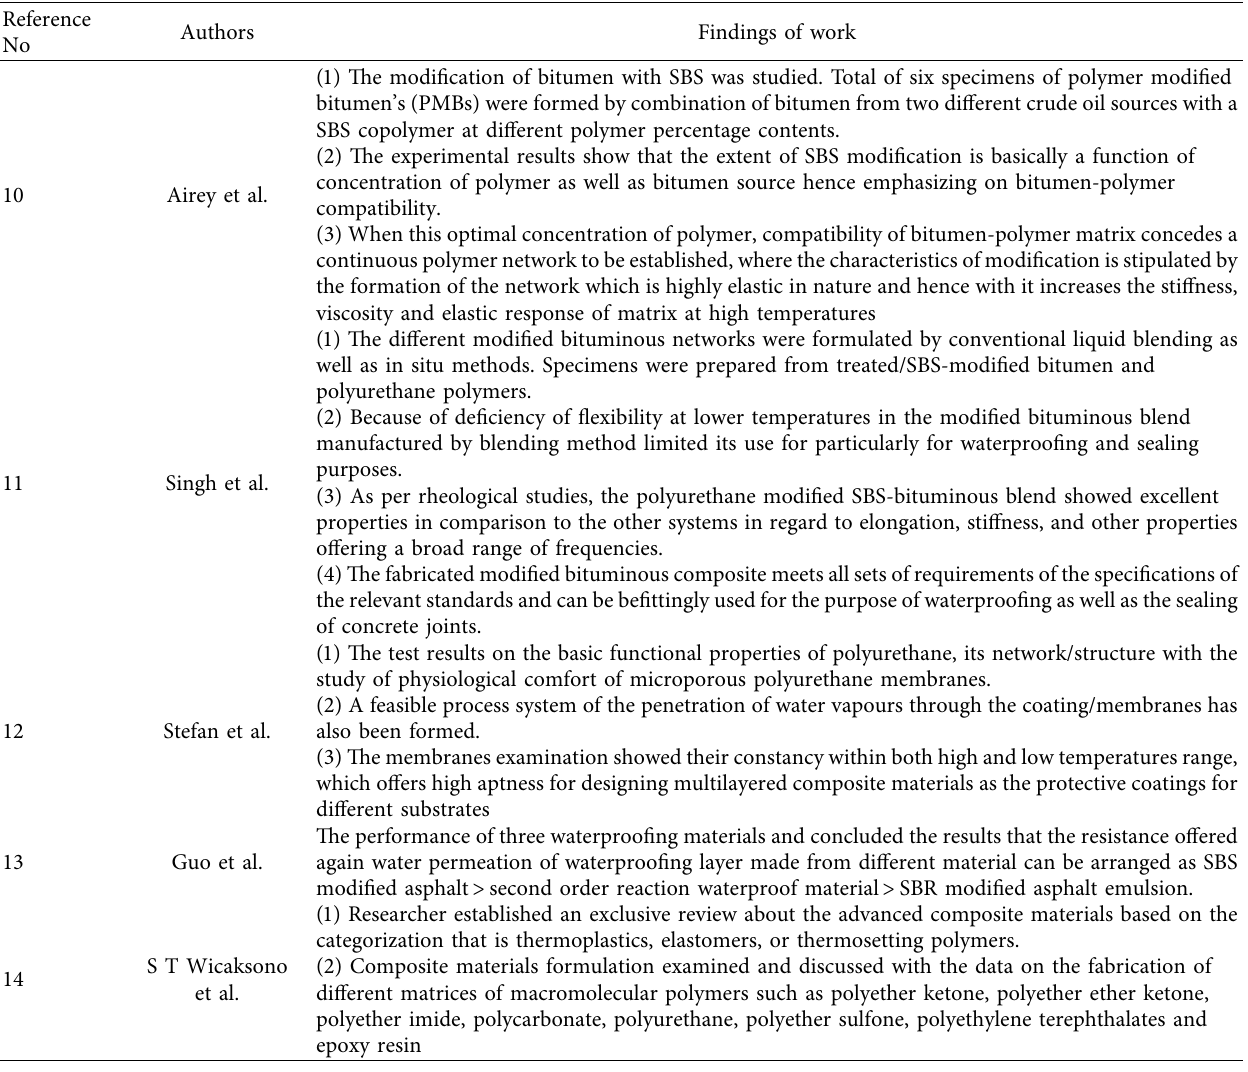
Table 2: Summary of previous work related to polymer-based